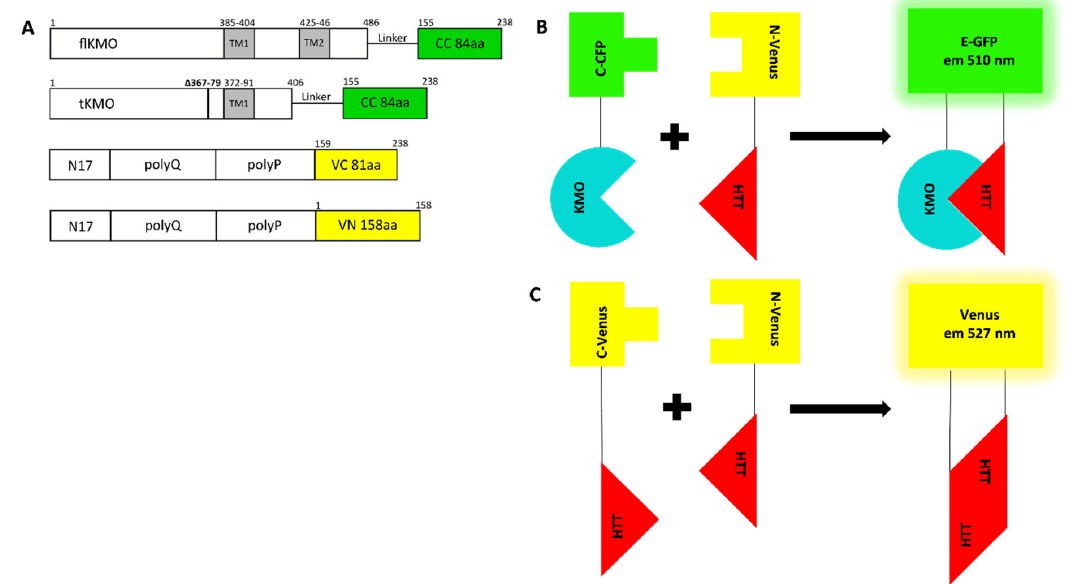
Figure 2. Schematic representation of BiFC models and their complementation pairs. ( A ) Schematic outline of the KMO and HTT BiFC constructs. flKMO/tKMO were fused C ‐ terminally to N ‐ terminus of CFP (CC) via (GGGGS) 2 linker. The HTT BiFC constructs were composed of the N17, polyglutamine (polyQ) and polyproline (polyP) domains fused to either C ‐ terminus or N ‐ terminus halves of Venus (VC or VN). For each of the ‐ VN or ‐ VC HTT BiFC constructs in the illustration there are versions with different polyQ lengths: 25Q ‐ VC, 19Q ‐ VN, 46Q ‐ VN, 97Q ‐ VC and 97Q ‐ VN. ( B , C ) Illustrations of BiFC combination pairs: ( B ) KMO and HTT pair that when interacting bring CC and VN together to form a fluorescence protein with 510 nm emission as in enhanced ‐ GFP (E ‐ GFP); ( C ) HTT pairs upon interactions, the two halves of Venus (VN and VC) re ‐ constitute with emission 527 nm. flKMO or tKMO were fused to the C ‐ terminus of CFP (flKMO ‐ CC and tKMO ‐ CC, respectively) (Figure 2A) and, as expected, flKMO ‐ CC was found to localise to mitochon ‐ dria (Figure S1). For HTT, we used previously validated HTT BiFC constructs where dif ‐ ferent HTT exon 1 fragments (19Q, 46Q and 97Q) were fused at the C ‐ termini to either half of Venus (C ‐ terminus or N ‐ terminus) [32] (Figure 3A). HEK293T cells were trans ‐ fected with both BiFC constructs, along with a plasmid expressing RFP as an internal con ‐ trol for transfection and to allow for normalisation of the BiFC signal. The average fluo ‐ rescence complementation of the KMO ‐ HTT BiFC signals revealed that KMO and HTT specifically interact in living cells, and this interaction decreases as the polyQ length in ‐ creases (Figure 3A), with a ~50% reduction in the interaction of flKMO ‐ 97Q complex in comparison to flKMO ‐ 19Q. Notably, despite the decreased interaction with increased polyQ length, flKMO ‐ CC interaction with 97Q ‐ VN was still above background levels (flKMO ‐ CC + VN ‐ backbone).